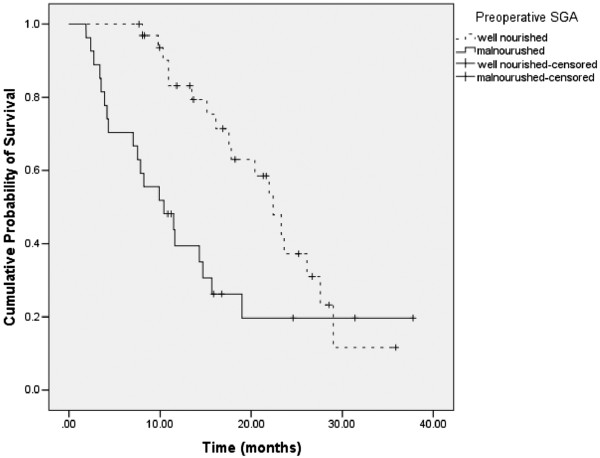
Survival stratified by 2 categories of preoperative SGA. Each drop in a probability curve indicates one or more events in that group. Vertical lines indicate censored patients, i.e., those who reached the end of their follow-up without experiencing death.